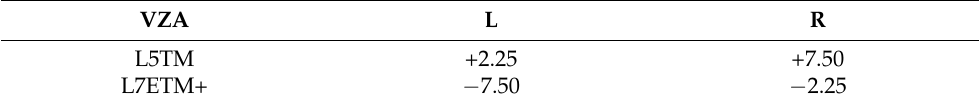
Table 3. Variation range of view zenith angle (VZA) in overlapped regions of TM/ETM+ images.